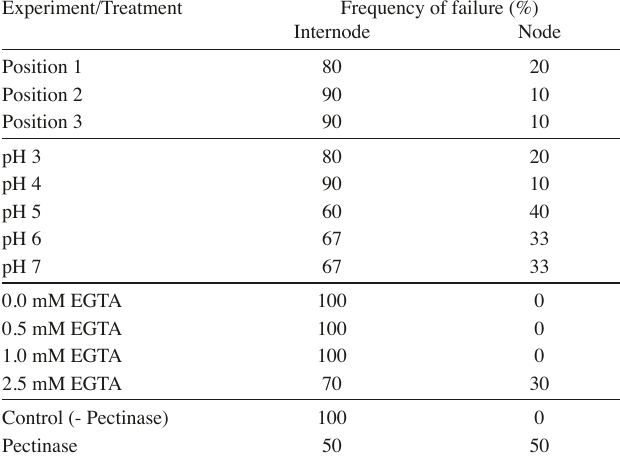
Tab. 1: Frequency of failure of node samples of Chara corallina at the node or the internode when subjected to uniaxial tensile tests (Position 1, 2, and 3 refer to the position of the specimen along the plant axis). Unless otherwise specified, internodes and nodes were taken from position 2 and 3.